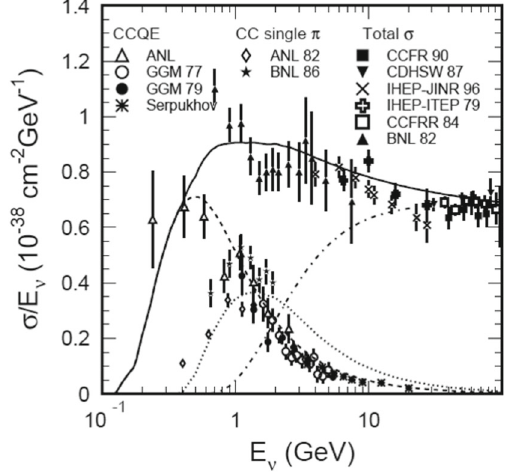
Fig. 10 A compilation of neutrino cross section data at the beginning of K2K. The compilation was done by the SOUDAN 2 collaboration. Data was not precise enough to use in K2K data analysis. The quasi- elastic interaction dominates below ∼ 1 GeV